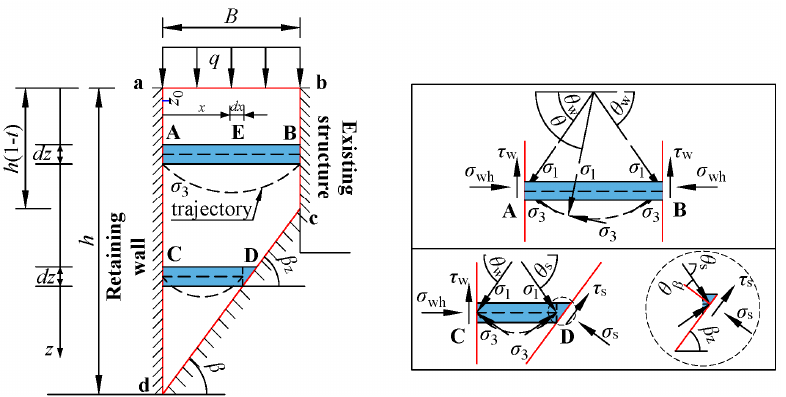
Figure 2. Stress analysis of horizontal soil strip within the slip wedge.